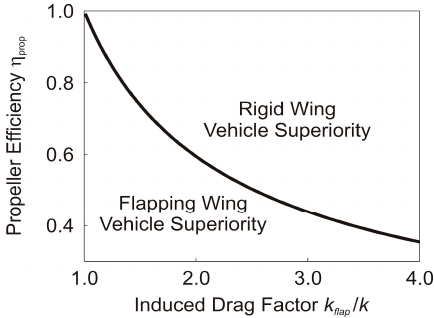
Figure 13. Regions of superiority of flapping and fixed wing vehicles.